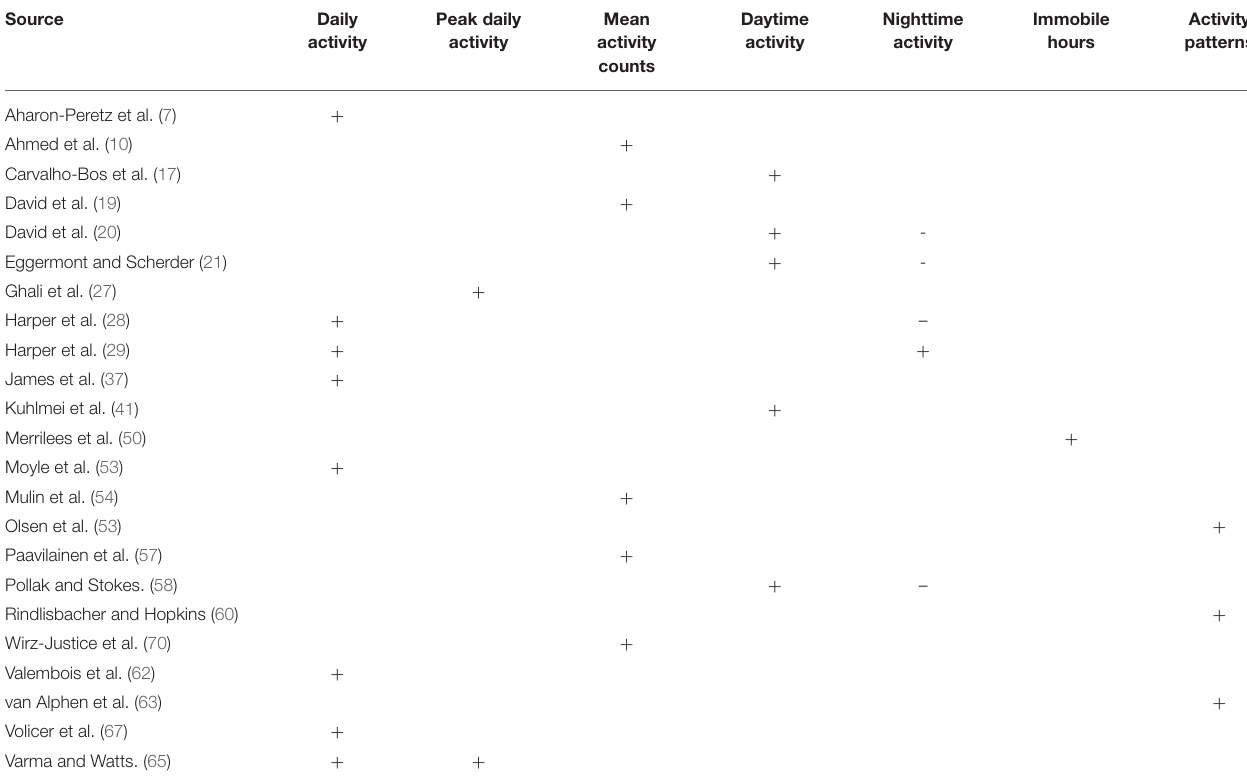
TABLE 3 | Specific outcome measures of daily activity reported by included